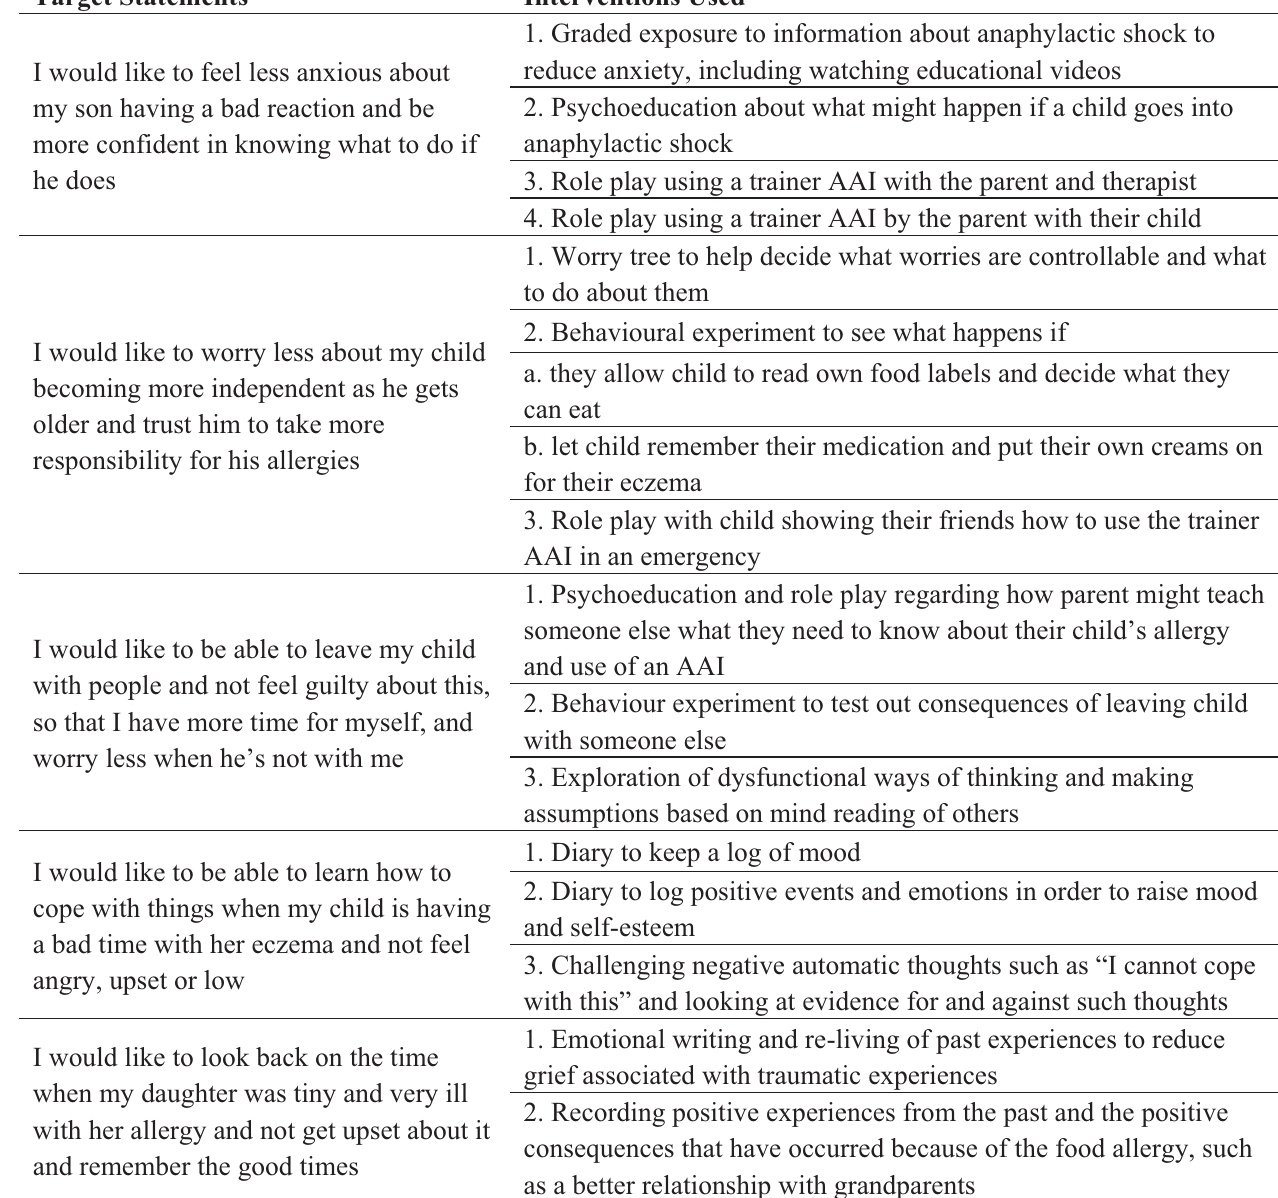
Table 3. Examples of end targets from participants with interventions utilised for